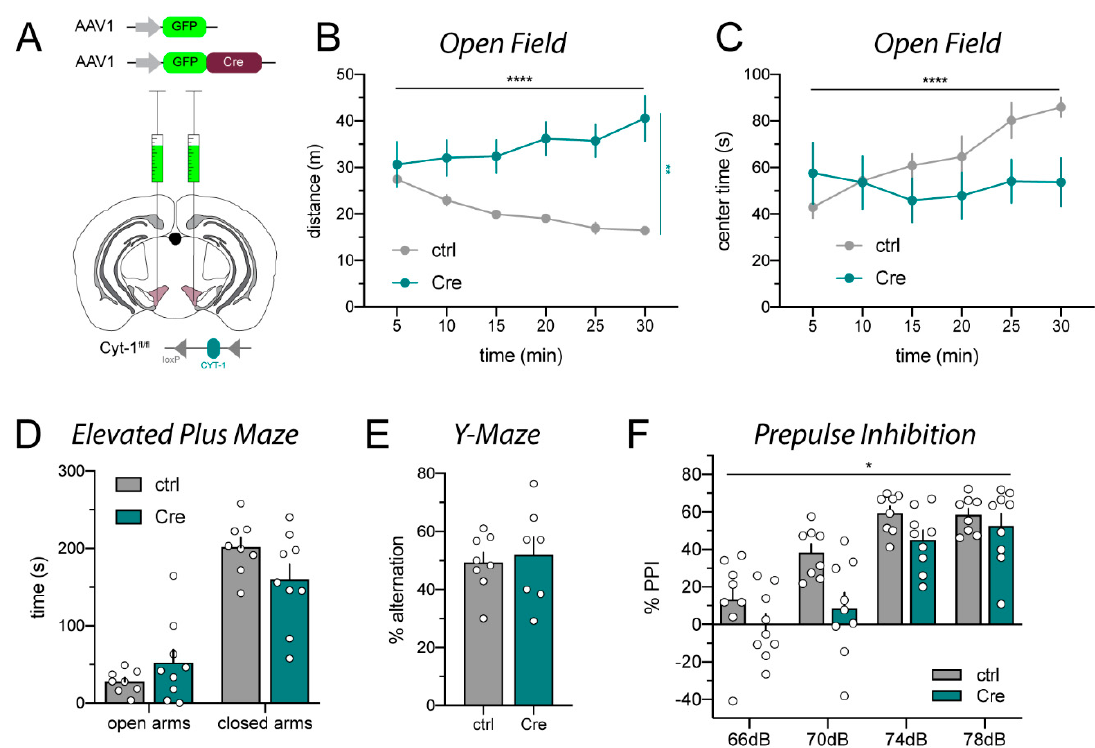
Figure 1. AAV1_Cre-GFP injections into the VTA of ErbB4 Cyt-1 fl/fl mice cause hyperactivity and sensorimotor gating deficits relative to AAV1_GFP injected ErbB4 Cyt-1 fl/fl controls. ( A ) Scheme visualizing bilateral injection of Cre (AAV1_Cre-GFP) and control (AAV1_GFP; both 10 13 GC/mL; for details see Figure S1) into the VTA of adult ErbB4 Cyt-1 fl/fl mice. ( B , C ) Locomotor activity in a novel environment was analyzed in the open field (ctrl n = 8, Cre n = 9). Cre-injected mice became hyperactive compared to control-injected mice ( B , two-way ANOVA, F(5,75) = 6.871, p < 0.0001 ****; genotype: p = 0.0013 **) and tend to spend less time in the center over time ( C , two-way ANOVA, F(5,75) = 7.106, p < 0.0001 ****; genotype: p = 0.2769). ( D ) Anxiety assessed in the elevated plus maze is unchanged (two-way ANOVA, F(1,15) = 2.848, p = 0.1122; genotype: p = 0.3752; ctrl n = 8, Cre n = 9). ( E ) Spontaneous alternation in the Y-maze is unaltered (unpaired t test, p = 0.7095; ctrl n = 8, Cre n = 7). ( F ) Prepulse inhibition is impaired in Cre-injected mice compared to controls (two-way ANOVA, F(3,45) = 2.237, genotype: p = 0.0334 *; ctrl n = 8, Cre n =